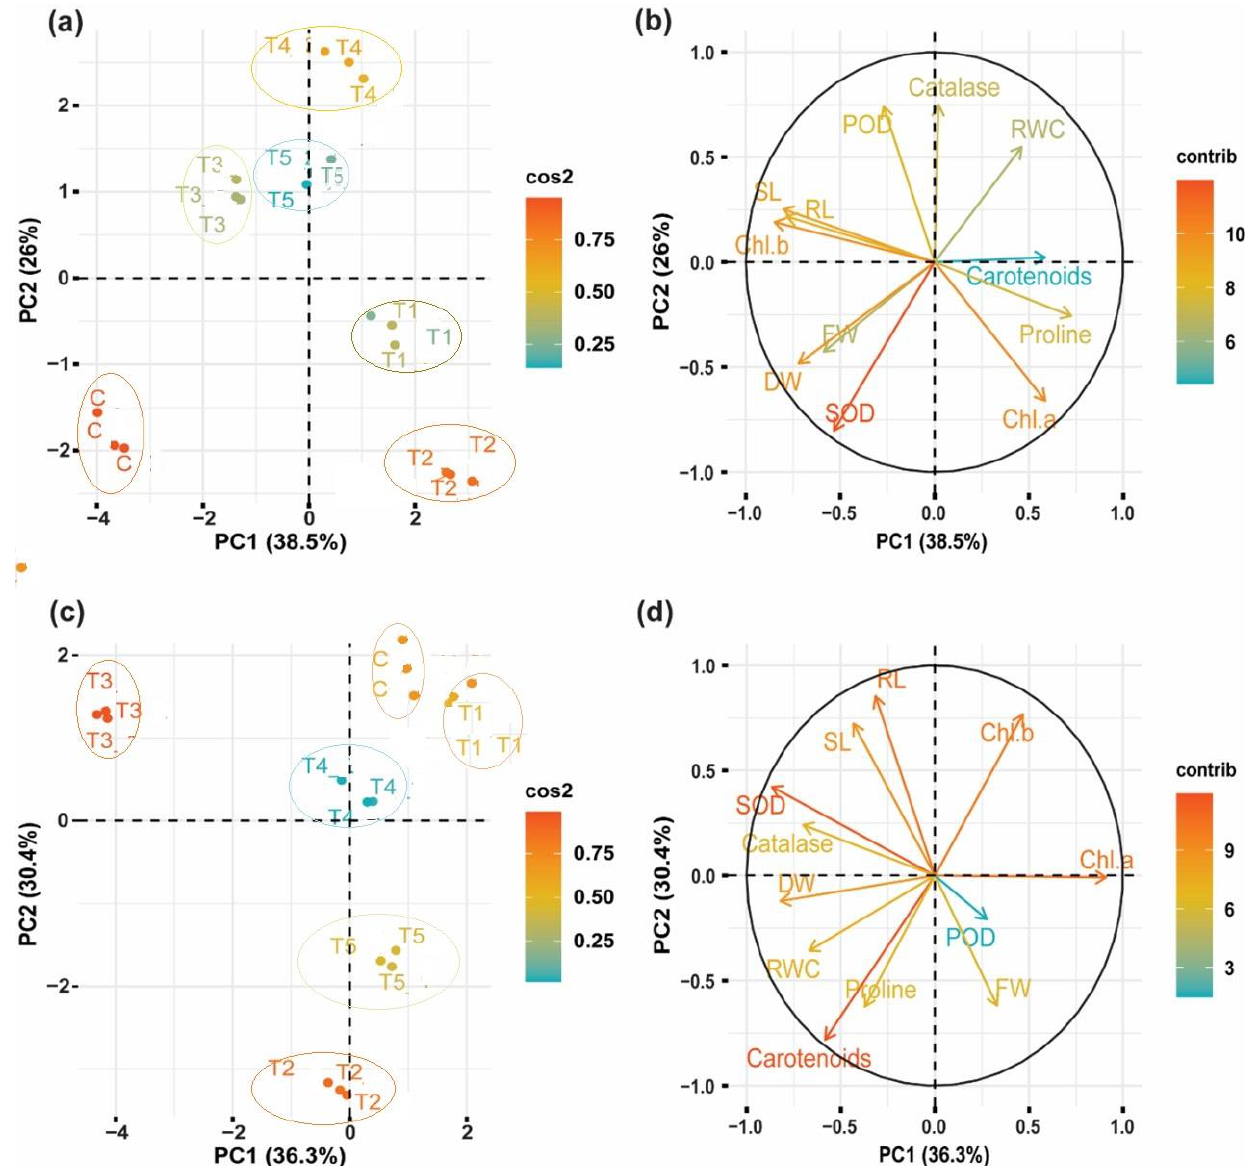
Figure 4. The PCA biplot shows the effect of K.rhizophilla inoculation on correlation among different growth attributes and treatments of pea varieties under 75 mM and 150 mM of NaCl stress. ( a ) The correlation among treatments of variety peas2009. ( b ) The effect of 14asp on correlation among growth variables of peas2009. ( c ) The correlation among treatments. ( d ) The correlation among variables of seedlings of variety 9800-10.